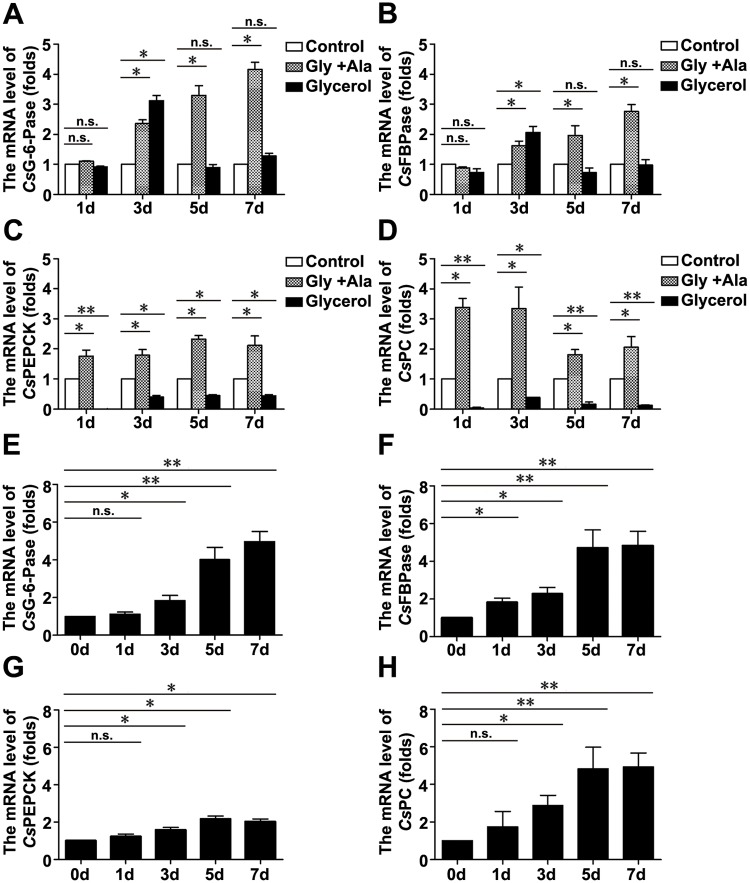
The mRNA levels of CsG-6-Pase, CsFBPase, CsPEPCK, and CsPC in 1 × Locke’s with or without the addition of different nutrients.The mRNA levels of CsG-6-Pase (A), CsFBPase (B), CsPEPCK (C), and CsPC (D). Time course of CsG-6-Pase (E), CsFBPase (F), CsPEPCK (G), and CsPC (H) mRNA levels in Gly + Ala. ANOVA was used to analyze the comparisons. *P < 0.05 and **P < 0.01 versus control (A-D) or 0 d (E-H); n.s., not significant.